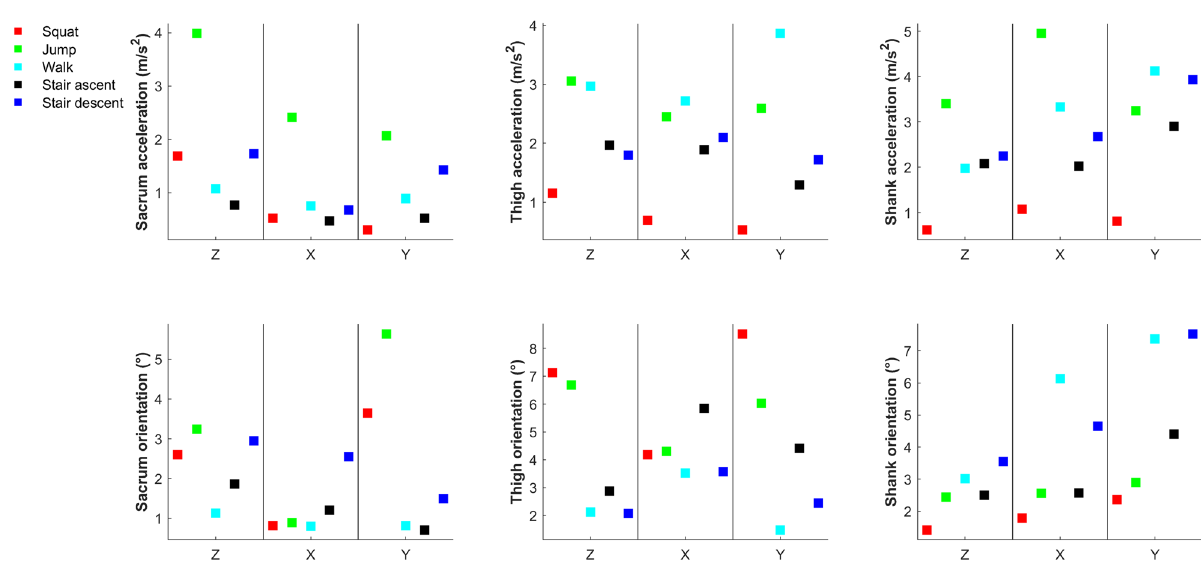
Figure 6. SEMs for acceleration and orientation range values (session 1 vs. session